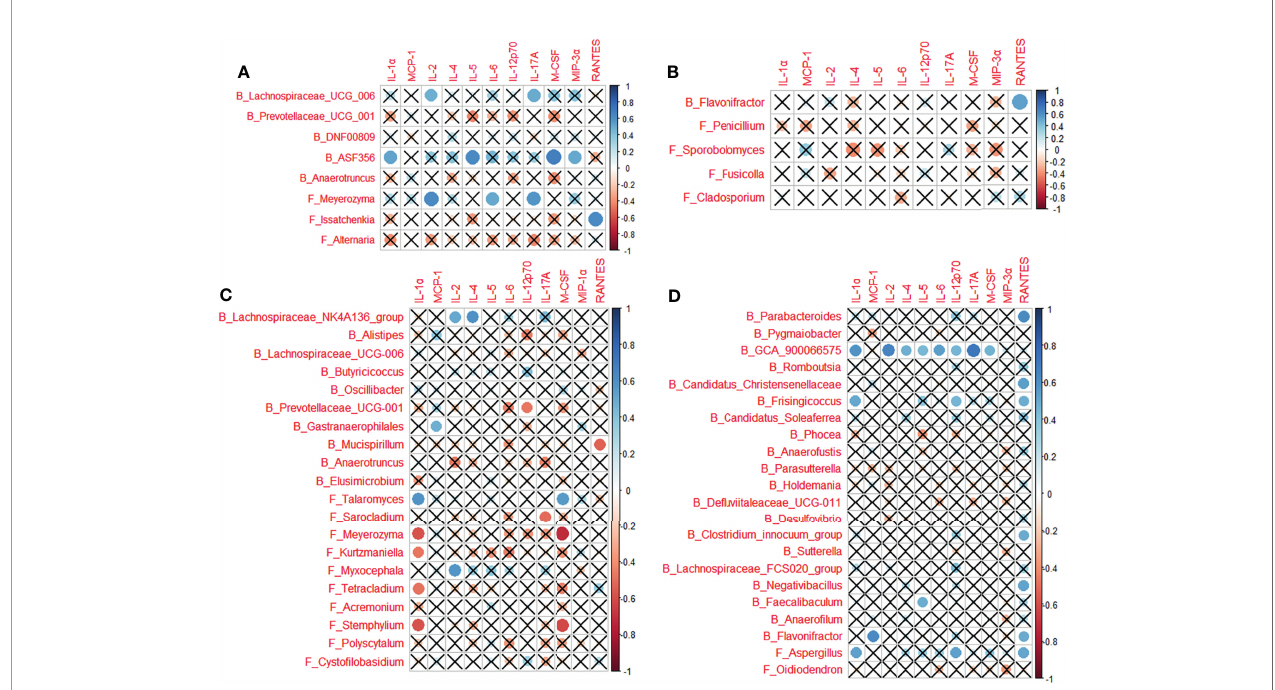
FIGURE 9 | Correlations between cytokines in the cytokine pro fi le and the microbes associated with each of (A) CP1_LI09, (B) CP2_LI09, (C) CP1_LI10, and (D) CP2_LI10 cohorts. “ B_ ” and “ F_ ” represent bacteria and fungi, respectively. Cross represents no positive or negative